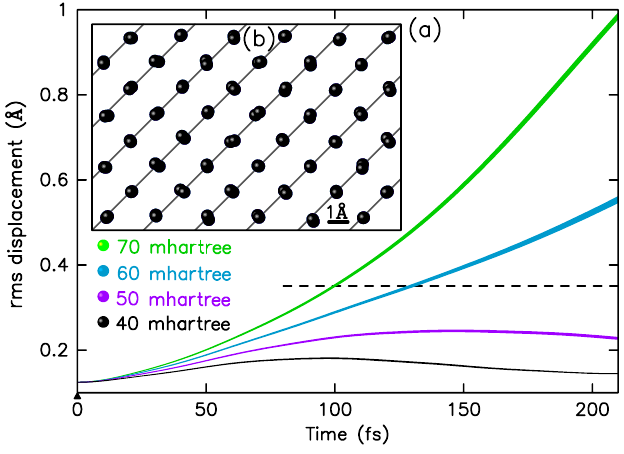
VIDEO 1. Animated version of Fig. 1. (a) Averaged root- mean-square displacements from equilibrium as a function of time. (b) Temporal evolution of the atomic coordinates from 0 to 210 fs of a particular run for each excitation strength. The atomic coordinates are projected in the z direction. The lines indicate ð 1 ; (cid:2) 1 ; 0 Þ lattice planes. The atoms move in the same directions during the first stages of nonthermal melting (60 and 70 mhar- tree) and thermal phonon squeezing (40 and 50